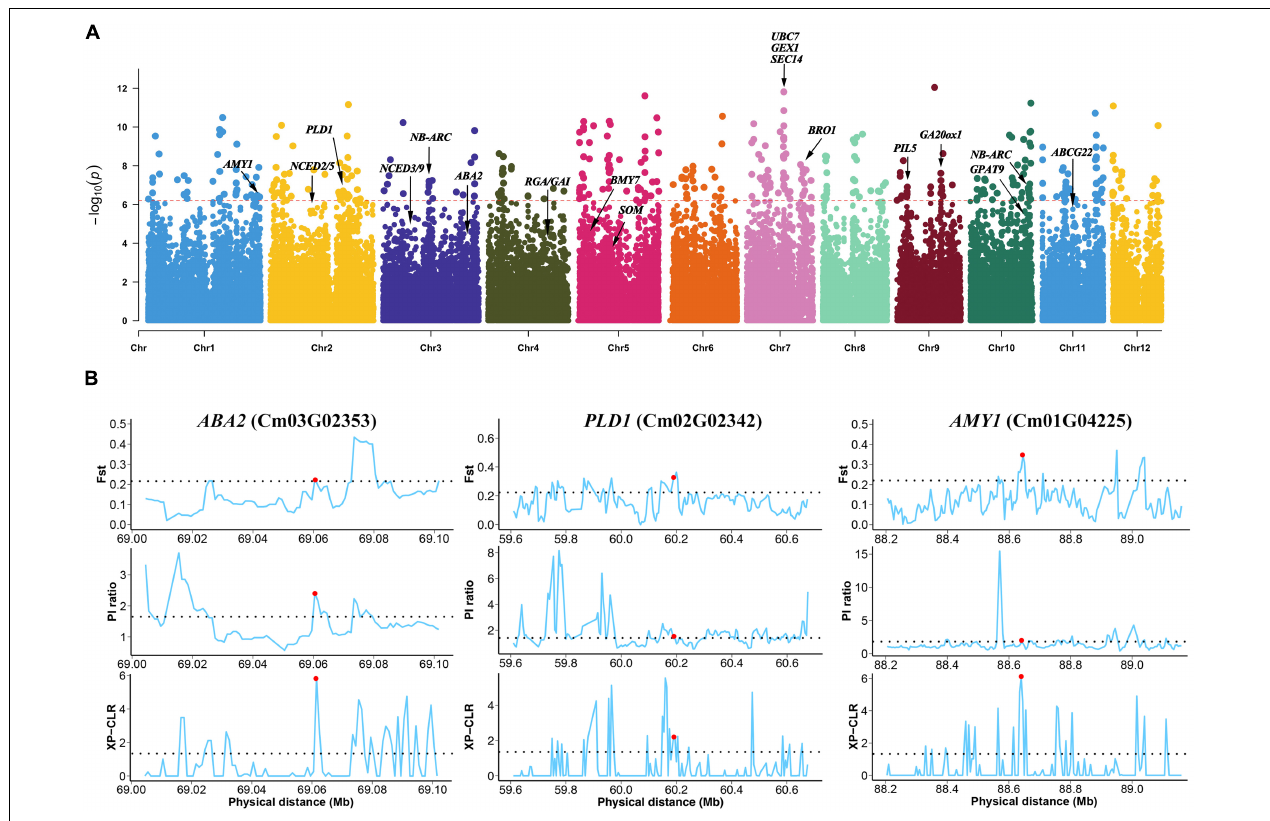
FIGURE 3 | Strong selection of genes between wild and cultivated Chinese chestnut. (A) Genome-wide distribution of selective sweeps in Chinese chestnut. (B) F ST , π , and XP-CLR values across the genomic regions of the ABA2 , PLD1 and AMY1 genes. The dashed horizontal line represents the selection threshold (top 5% of the genome). Red dots denote the genes that are connected.